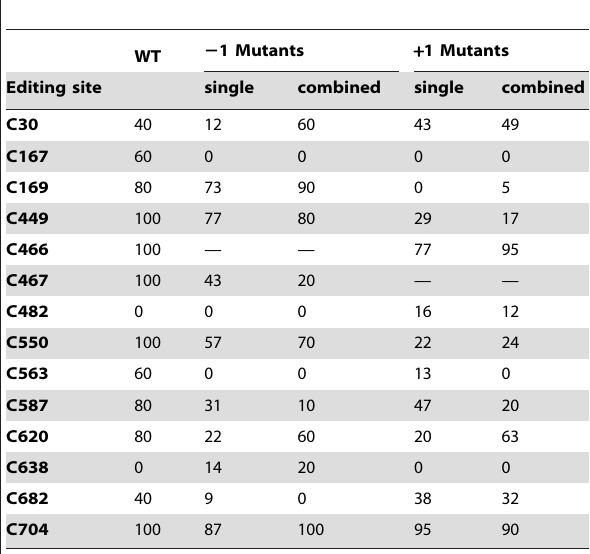
Table 1. Comparison of RNA editing in single and combined 2 1 or + 1 mutants.